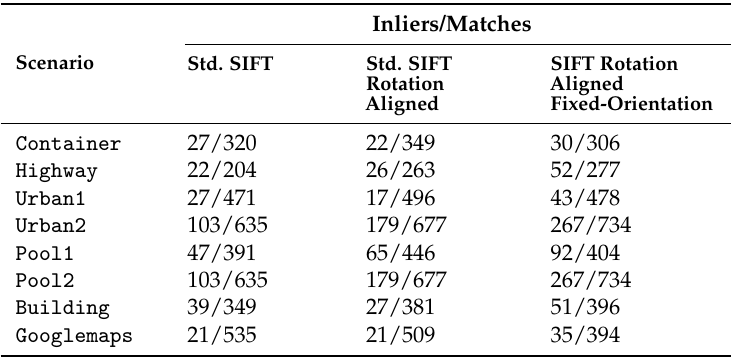
Table 4. Analysis of the influence of image rotation on matching performance. Inliers and matches for downsampled UAV images and cropped aerial images, rotation-aligned UAV images and rotation-aligned UAV images with fixed orientation in the SIFT-detector. Std., standard.